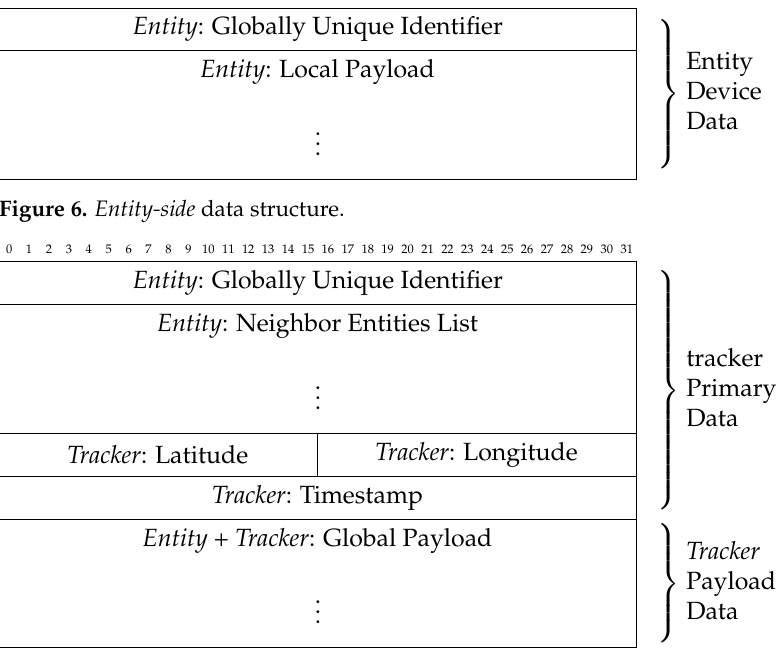
Figure 7. Tracker-side data